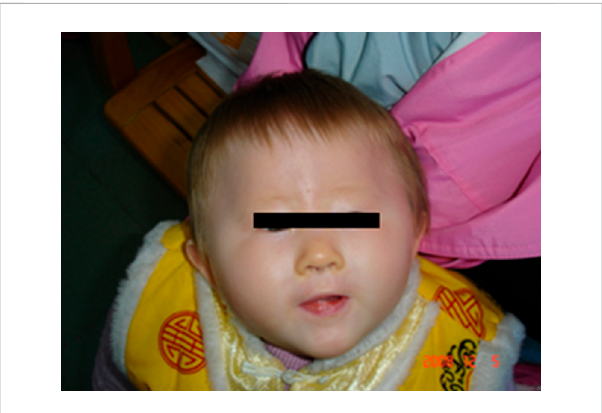
FIGURE 1 DNA sequencing results of family 1. Proband 1 carried homozygous mutation c.1327G > A in the p gene; her father was wild- type (c.1327G); her mother carried heterozygous mutation c.1327G > A/G; the fetus carried heterozygous mutation c.1327G > A/G.